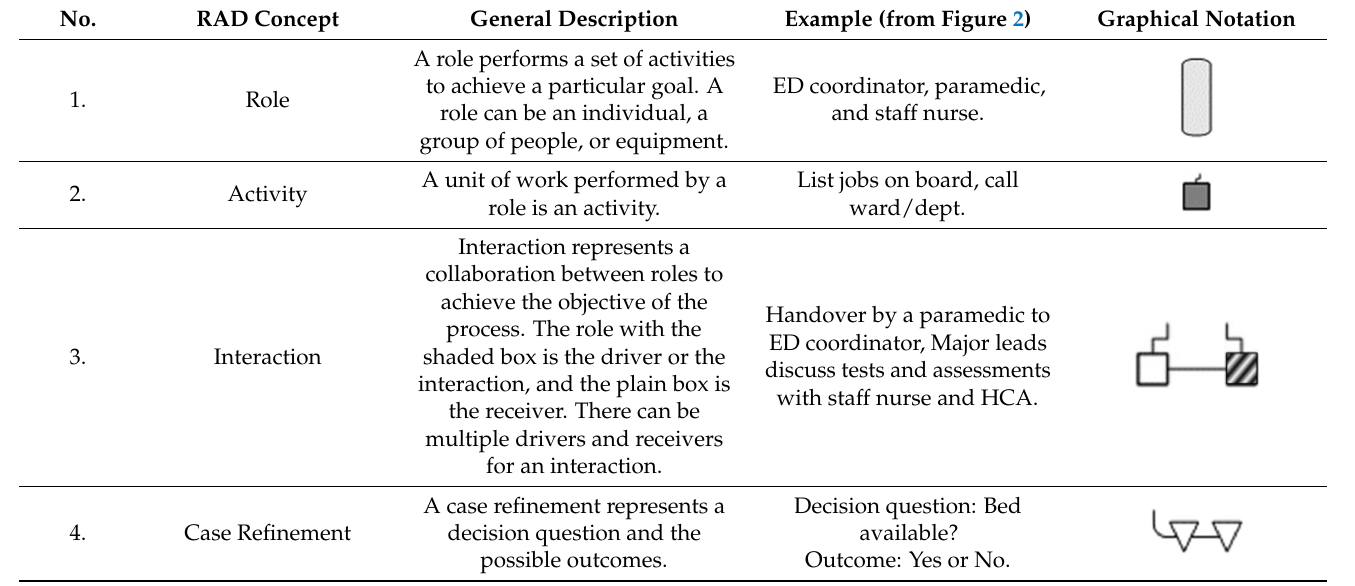
Table A1. A description of RAD concepts and corresponding graphical representation